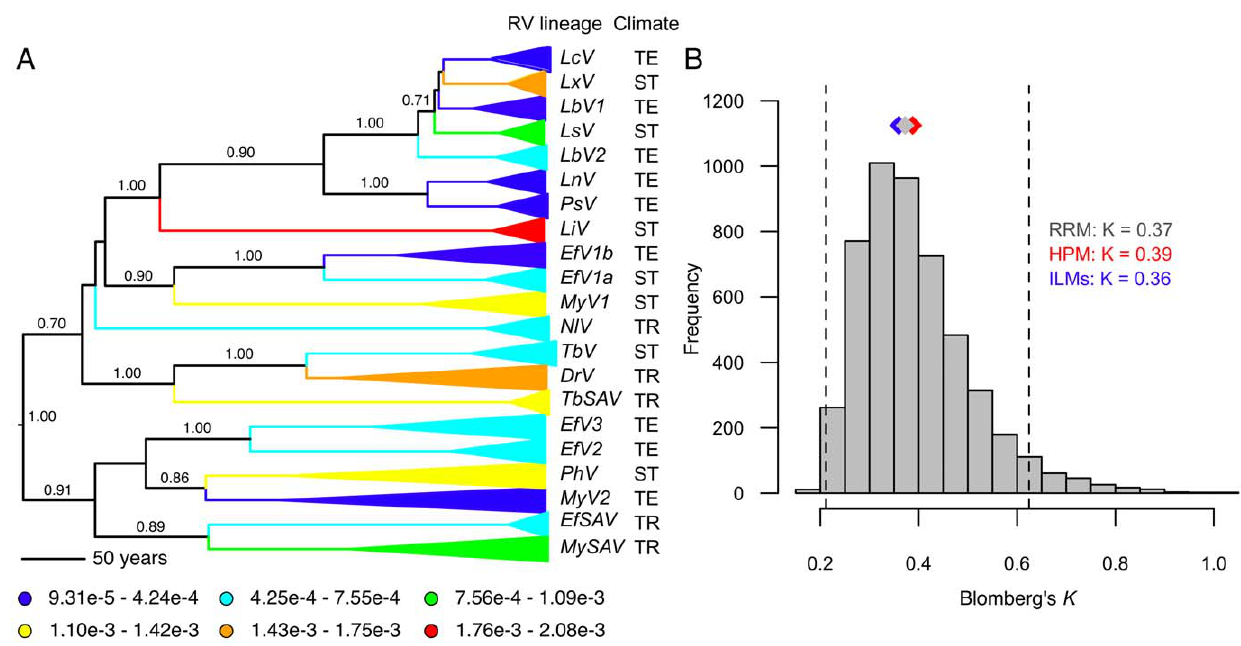
Figure 2. Evolutionary lability of viral substitution rates in the rabies virus phylogeny. (A) Bayesian phylogenetic tree of bat rabies viruses with viral lineage names and climatic regions denoted in black (TE: temperate; ST: subtropical; TR: tropical). Host-associated lineages are condensed to triangles connecting the most recent common ancestor to the sampled branches. Lineages are colored along a blue (slowest) to red (fastest) continuum according to evolutionary rate in CP 3 using estimates from the Independent Lineage Models (ILMs). Bayesian posterior support values ( . 0.70) are given above branches to the lineage level only. All colored lineages received Bayesian posterior support values of $ 0.91. (B) Frequency histogram of expected values of Blomberg’s K from 5000 random assignments of substitution rates estimated from the ILM to lineages. Dashed lines indicate 95% bounds of the null distribution and diamonds denote the median values of K for the randomized rate model, RRM (gray), the ILMs (blue), and the HPM (red).